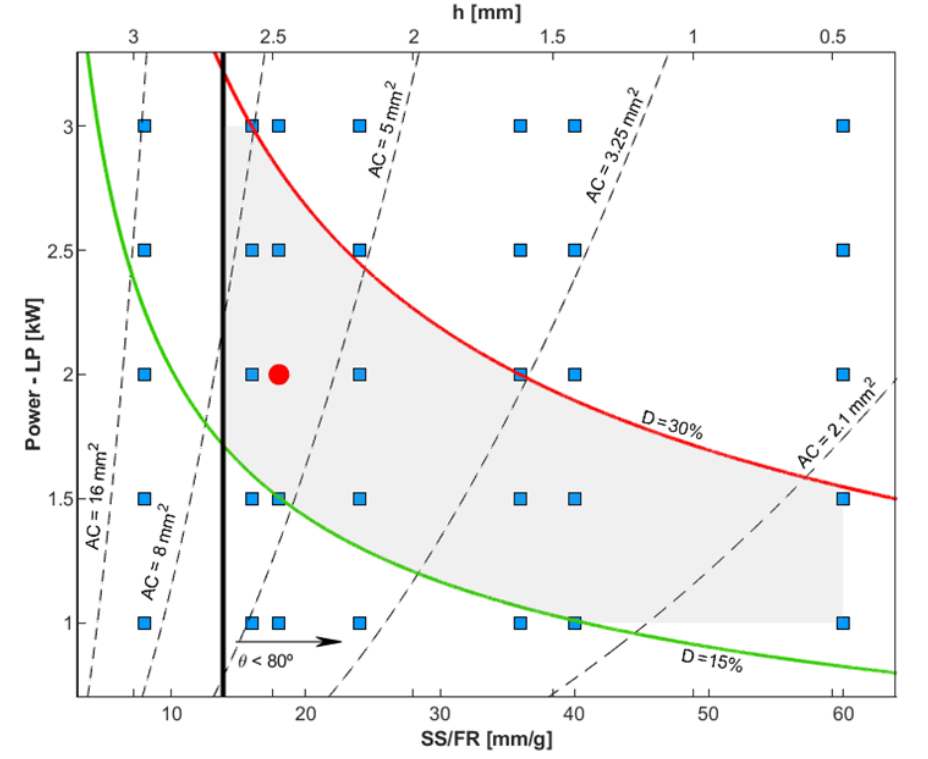
Figure 5. DLD process window map of M625 for additive manufacturing of single tracks. Red point represents the experimental I2_6_20 condition.